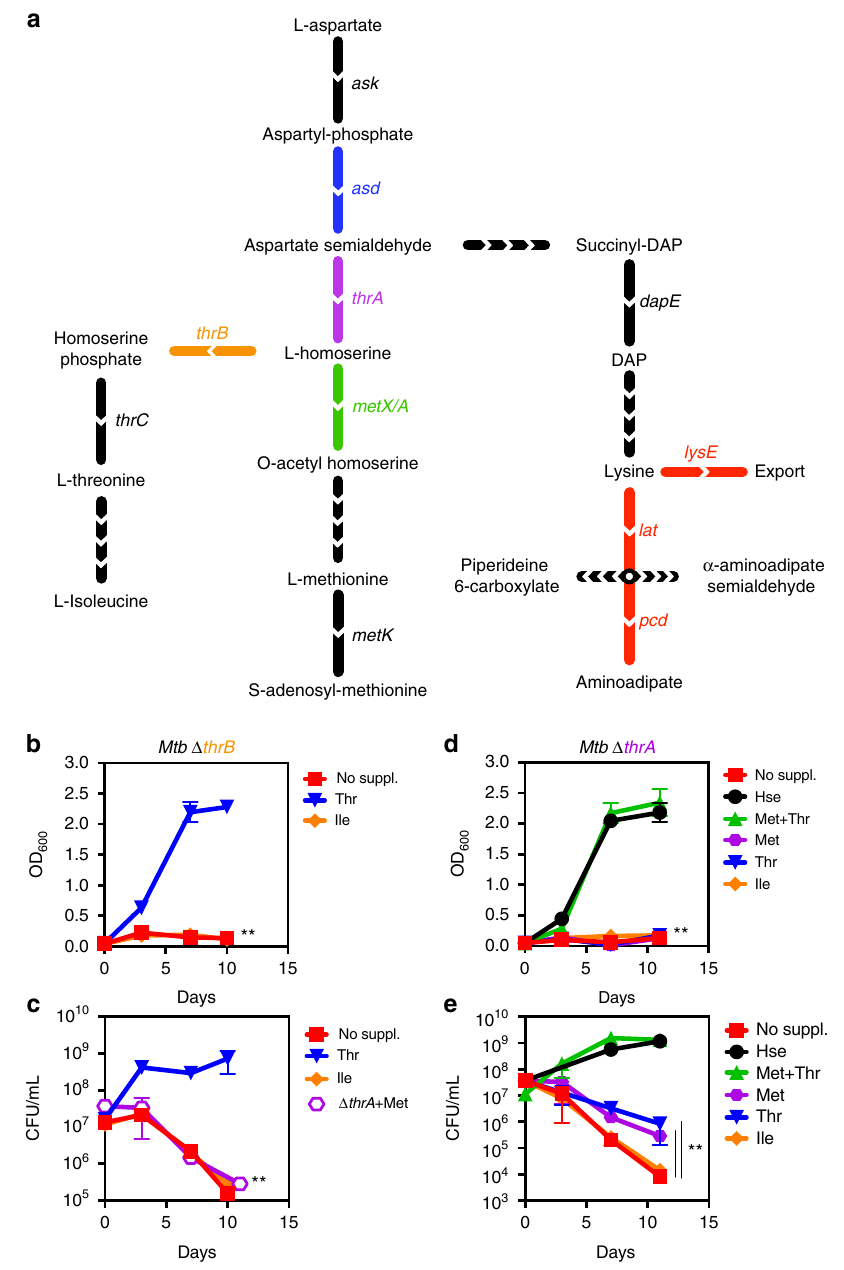
Fig. 1 Inactivation of homoserine dehydrogenase and homoserine kinase is bactericidal. a The aspartate family amino acid biosynthesis pathway